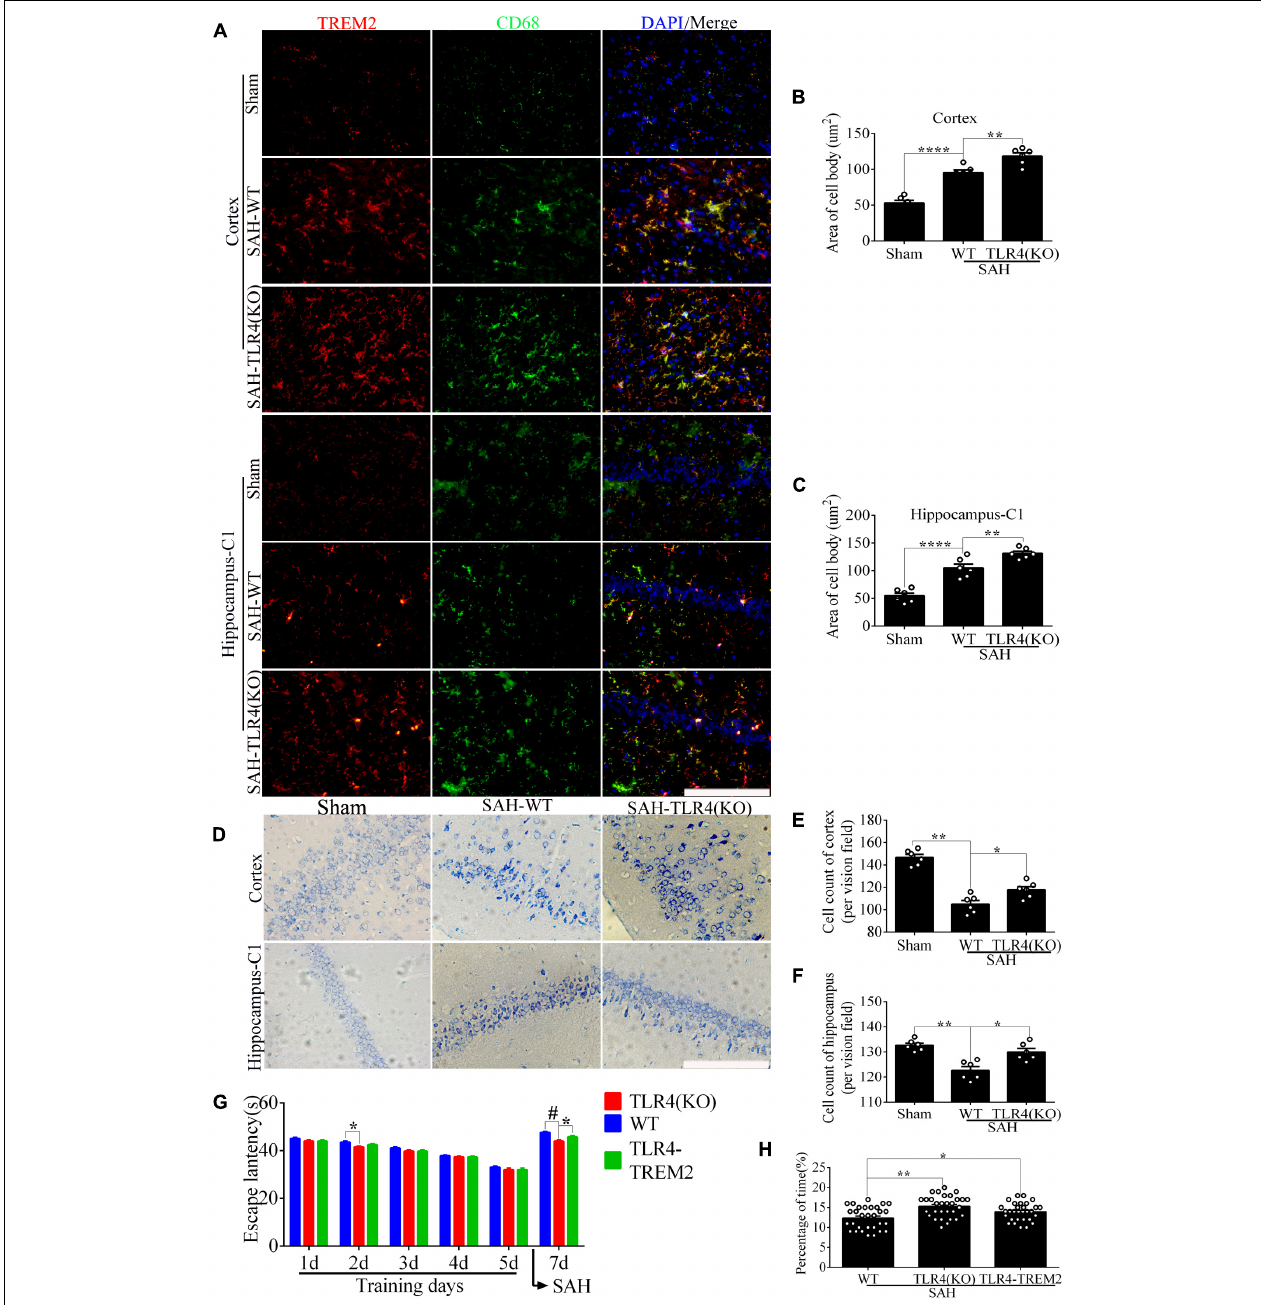
FIGURE 9 | Toll-like receptor 4 ( TLR4 ) deficiency ameliorates neuronal damage and improves neurological dysfunction. (A–C) Double immunofluorescence staining showed the triggering receptor expressed on myeloid cells 2 ( TREM2 )/CD68-positive cells in the cortex and hippocampus after subarachnoid hemorrhage (SAH). (D–F) Nissl staining and quantitative number of survived neurons. (G) Comparison of the escape latency on the navigation test on days 1, 2, 3, 4, 5, and 7. The SAH models were performed on day 6. (H) Comparison of the time spent in the target quadrant after removal of the platform on day 7. These data are shown as mean ± SEM ( TLR4 - TREM2 : Knocking down the TREM2 in the TLR4 -KO mice; *p < 0.05, ** p < 0.01, *** p < 0.001, *** p < 0.001, **** p < 0.001, # p <0.001; scale bar = 25 µ